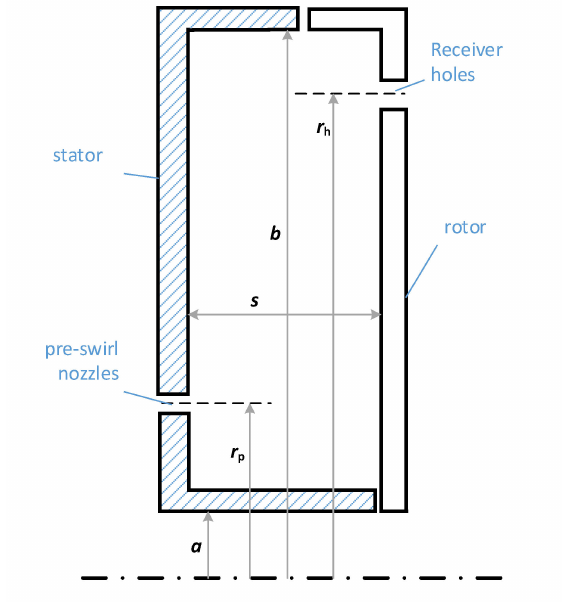
Figure 1. Schematic diagram of the direct-transfer pre-swirl rotor-stator system in this paper.